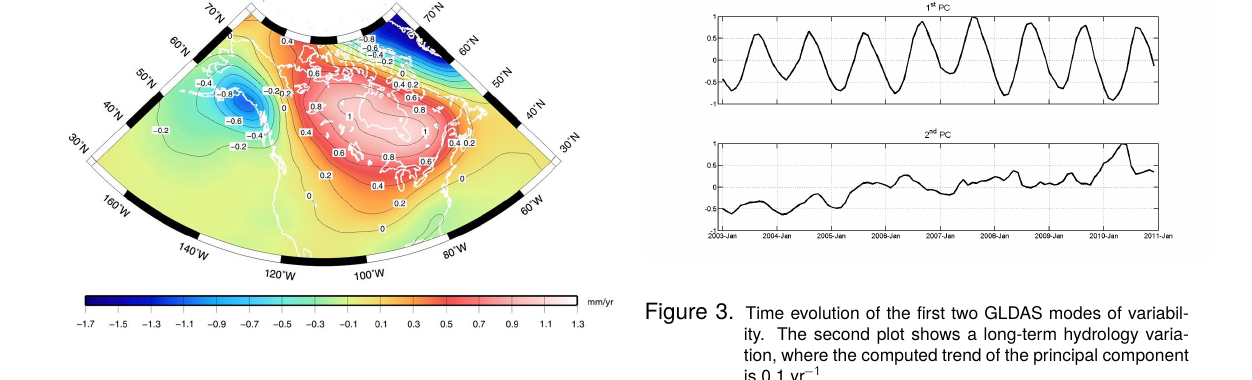
Figure 1. 2003-2009 GRACE-derived geoid rates for North America computed by averaging six monthly GRACE solutions; unit is mm/yr.